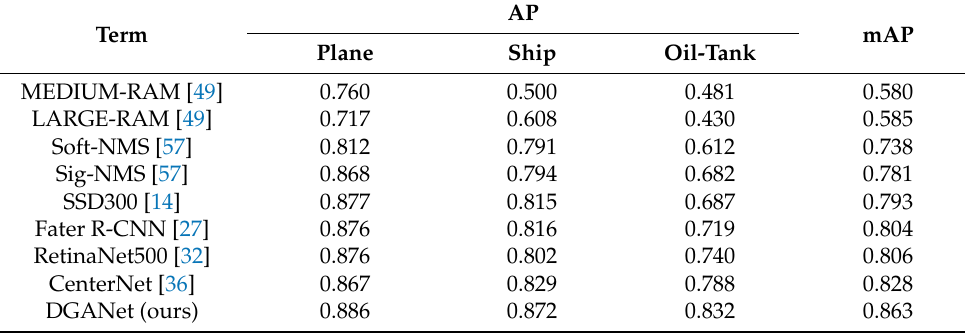
Table 6. Evaluation results on the LEVIR dataset.